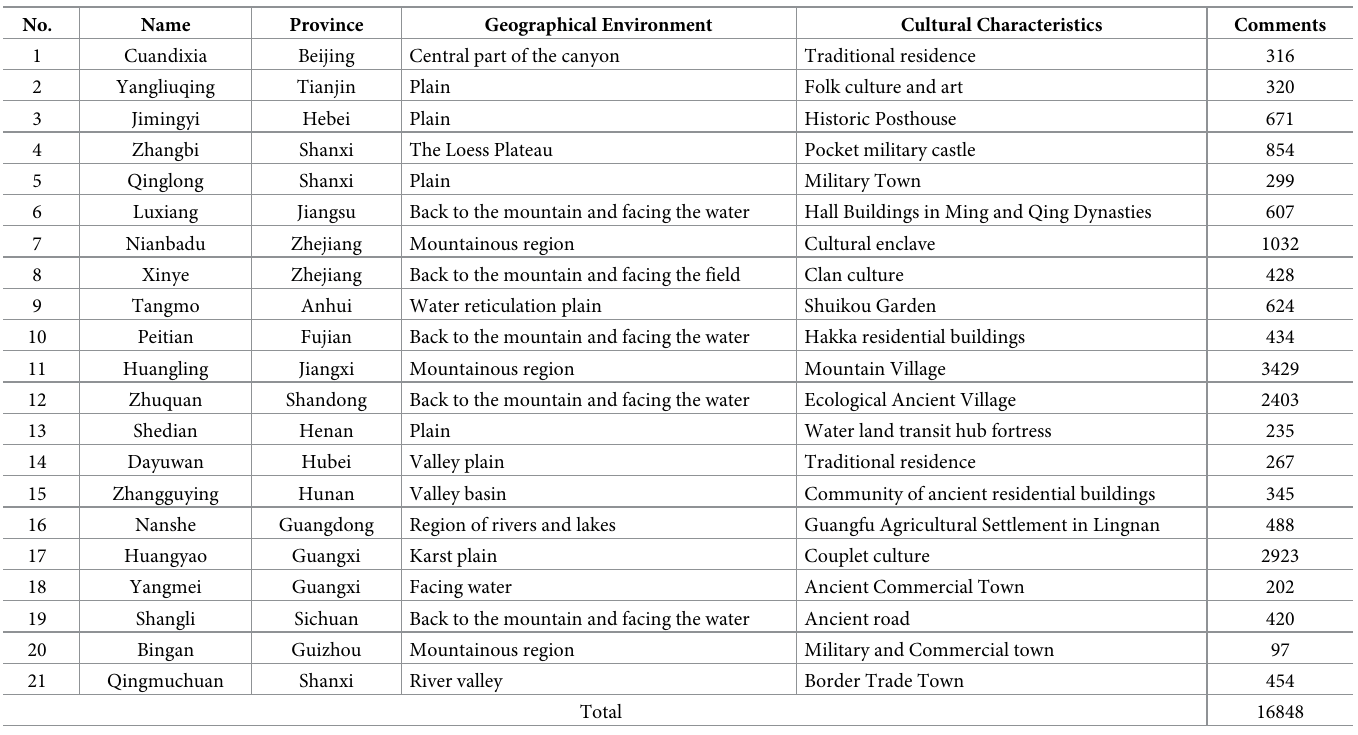
Table 2. Research sample